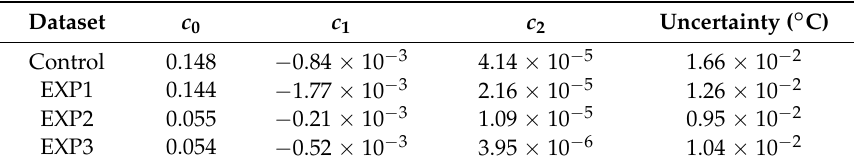
Figure 5. The relationship between the hourly averaged σ 1min and Tb IRT of the clear sky. The solid lines over the scatter plots are the best-fit lines used for the estimation of the expected temporal variation ( σ E CLR ) of clear sky (Equation (A3)). Table 5. The coefficients of the empirical Equation (A3) for the four experimental datasets. The uncertainty represents a best-fit error as a standard deviation of the difference between the hourly average σ 1min and estimated σ E CLR .